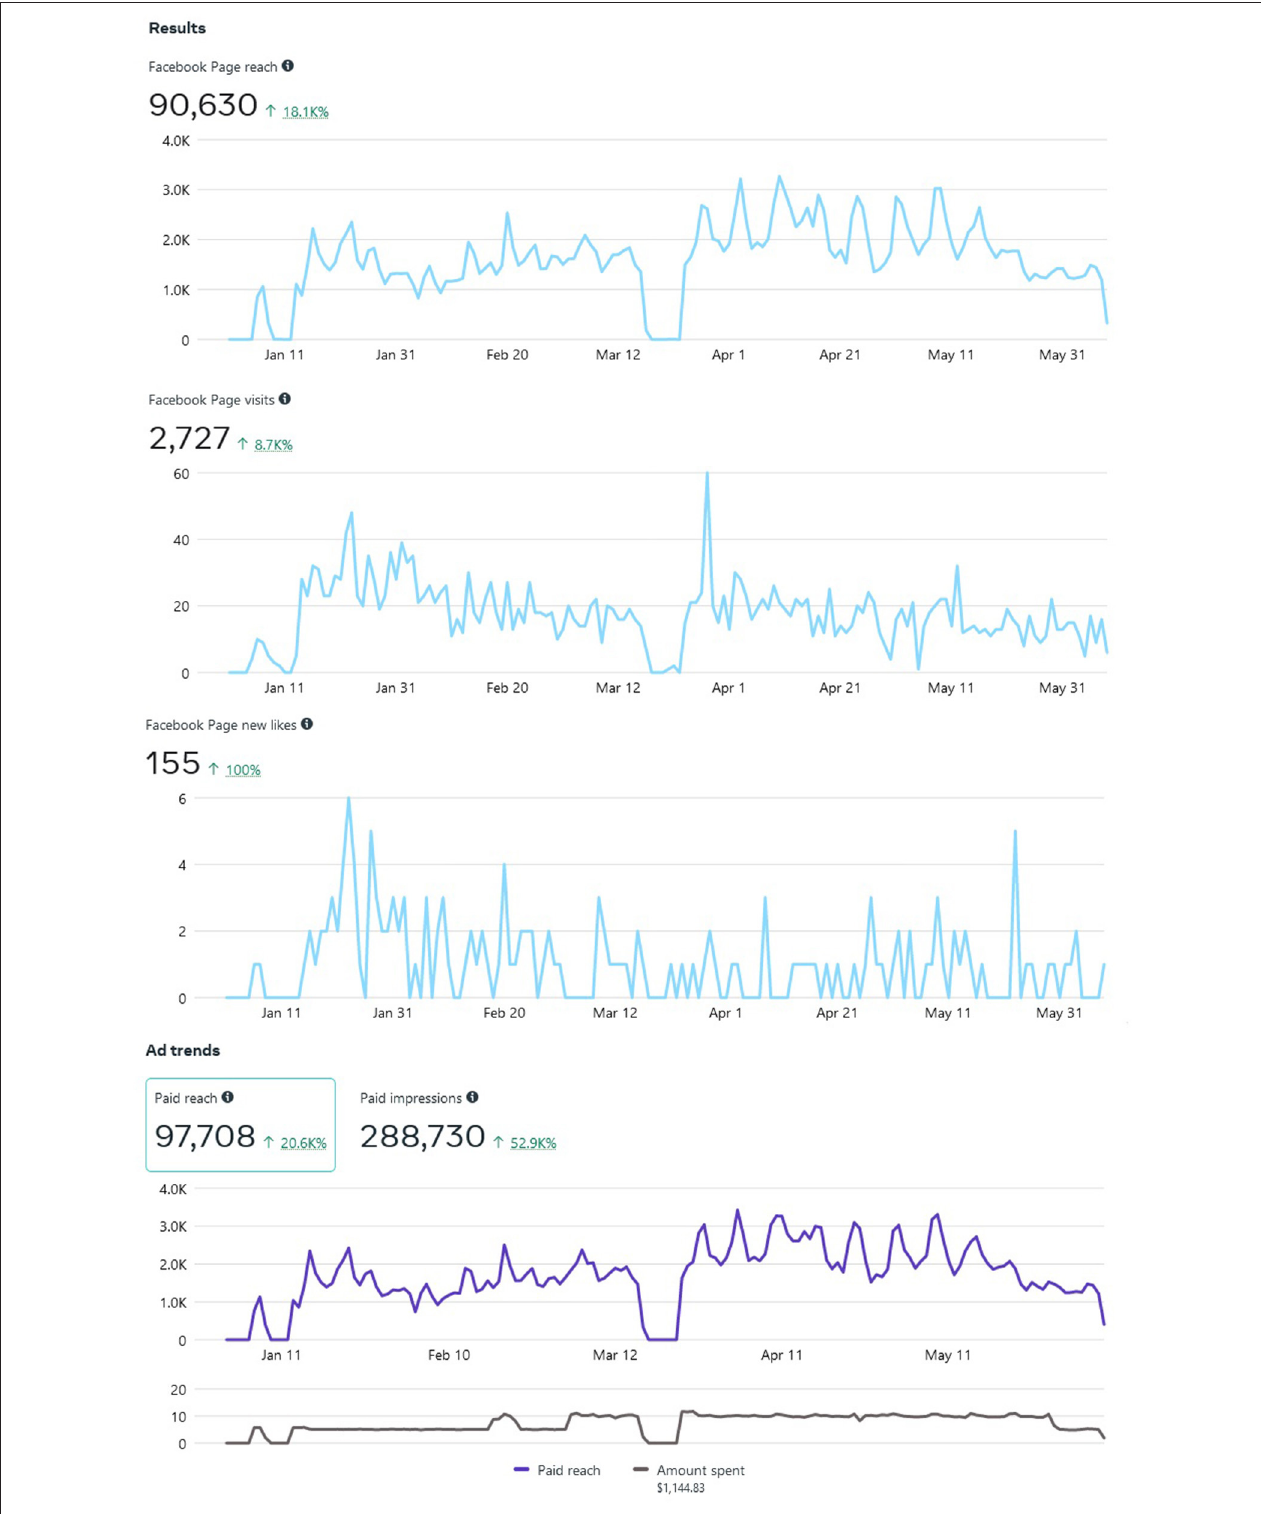
FIGURE 3 | Facebook Page Reach, Page Visits, and Page Likes from 5 January 2022 to 7 June 2022.